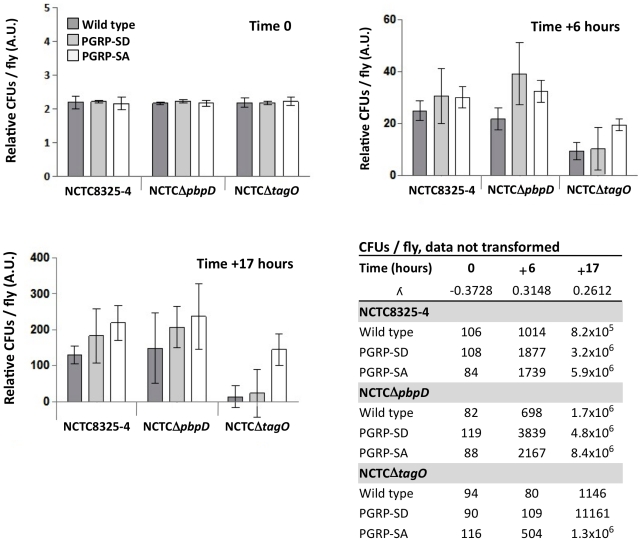
PGRP-SA is fundamental for controlling bacterial numbers in flies infected with a S. aureus mutant that lacks WTA.Wild type flies, and those lacking PGRP-SD or PGRP-SA, were infected with different S. aureus strains: NCTC8325-4 is the wild type; NCTCΔpbpD is a mutant that produces WTA but has a PG similar to NCTCΔtagO, both exhibiting reduced cross-linking; NCTCΔtagO lacks WTA. The table gives the mean CFUs per fly (from 3 independent experiments). For each time point, the CFUs per fly data set was transformed via a Box-Cox transformation (which returns a λ number, where data-point  =  data-pointλ – 1/λ) and represented as means with 95% confidence intervals. Flies were inoculated with a low (∼100 CFUs per fly) and comparable number of bacteria (Time 0; Two-way ANOVA did not reveal significant differences, P>0.05), and CFUs per fly were determined at 6 and 17 hours post-infection. In contrast to NCTC8325-4 and NCTCΔpbpD, the number of NCTCΔtagO bacteria did not significantly increase in the wild type or PGRP-SD mutant background during the period of infection (Table); however, in the PGRP-SA mutant the number of bacteria increased significantly for all strains (P<0.05, Repeated Measures One-way ANOVA). Two-way ANOVA of the CFUs data at Time +17 hours revealed a significant interaction (P<0.05) between the bacteria and fly strains, which was due to the large increase of NCTCΔtagO CFUs in the PGRP-SA mutant, whilst differences in CFUs were similar for NCTC8325-4 and NCTCΔpbpD. One-way ANOVA and 95% Tukey's HSD intervals were used to look for factor differences at this time. For each fly background NCTC8325-4 and NCTCΔpbpD CFUs were equivalent (P>0.05). NCTCΔtagO CFUs in the wild type and PGRP-SD backgrounds were similar (P>0.05), but separated from all other values (P<0.05). In the PGRP-SA mutant, NCTCΔtagO CFUs reached levels seen with the other bacteria in wild type and PGRP-SD flies. The negative error bars for the NCTCΔtagO infection occur because of large variation of the biological repeats. This is consistent with the fact that NCTCΔtagO occasionally causes a lethal infection in both the wild type and PGRP-SD backgrounds.